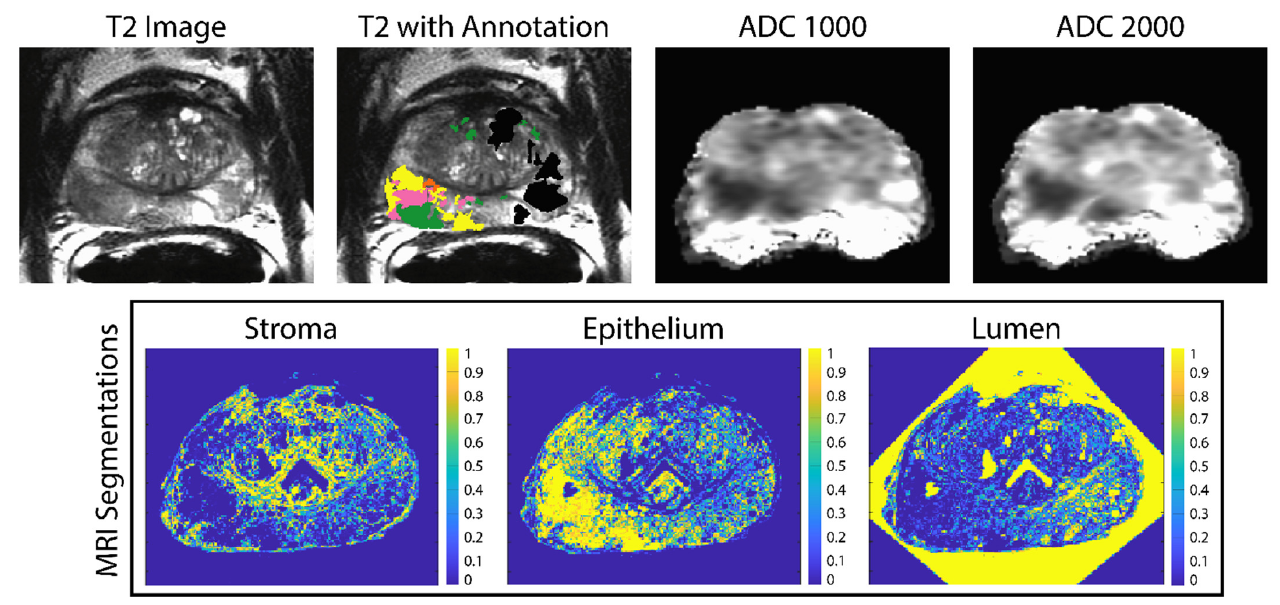
Figure 2. Example of the ADC maps and pathologist annotations aligned to the T2-weighted image ( top ). The annotation key is as follows: G4FG (yellow) G4CG (pink), G3 (green) and benign atrophy (black). The stroma epithelium and lumen segmentations shown on the ( bottom ) are likewise aligned to the T2.